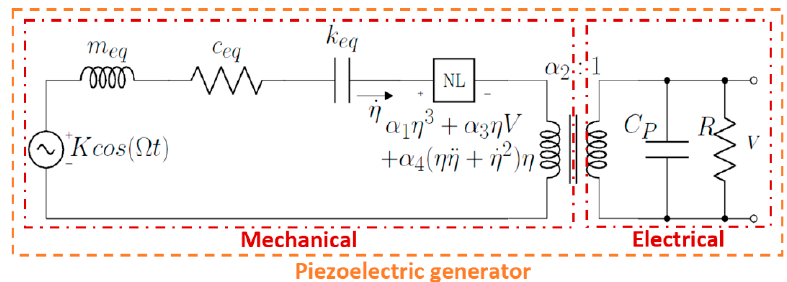
Figure 3. Equivalent circuit model of the harvester.